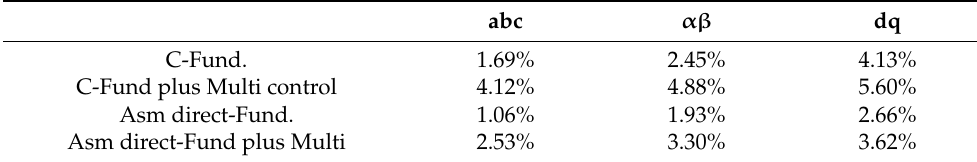
Table 7. Measured computational effort—% of sample period. abc αβ dq C-Fund. 1.69% 2.45% 4.13% C-Fund plus Multi control 4.12% 4.88% Asm direct-Fund. Asm direct-Fund plus